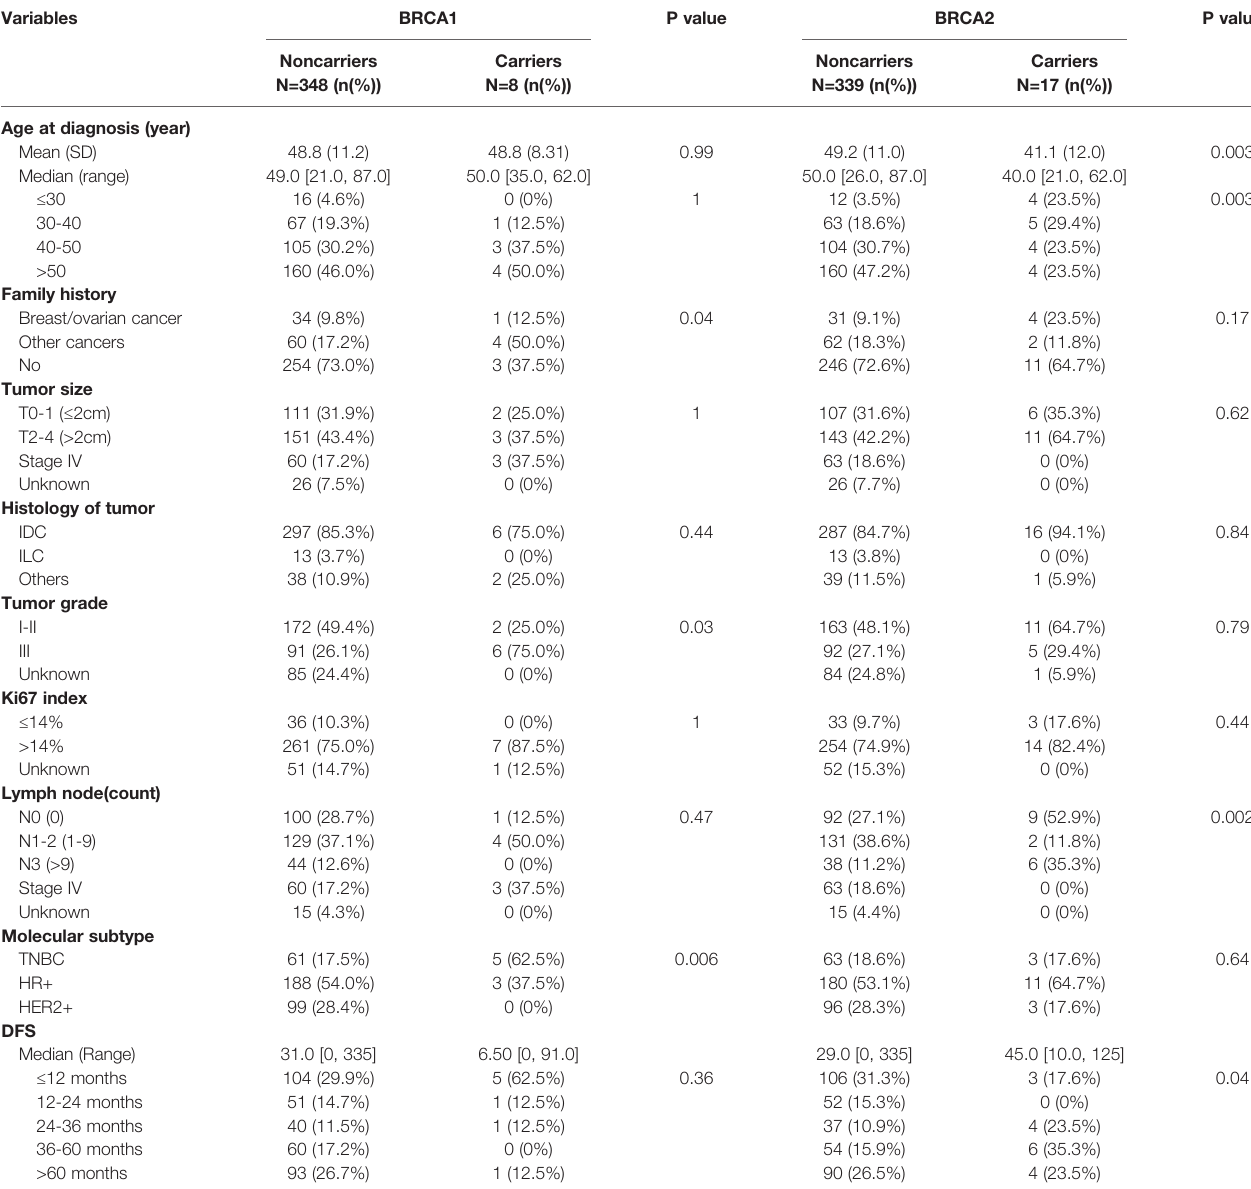
TABLE 2 | Comparison of genomic alterations between BRCA1/2 mutation carriers and noncarrier among different prognostic clinical variables.